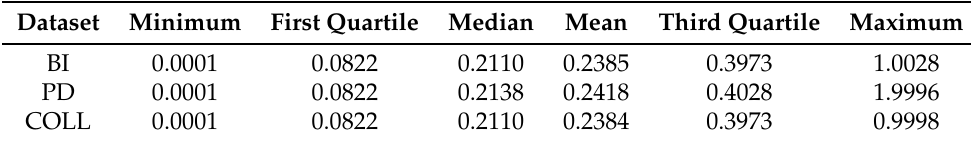
Table 2. Summary of EARNED_EXPOSURE across the three